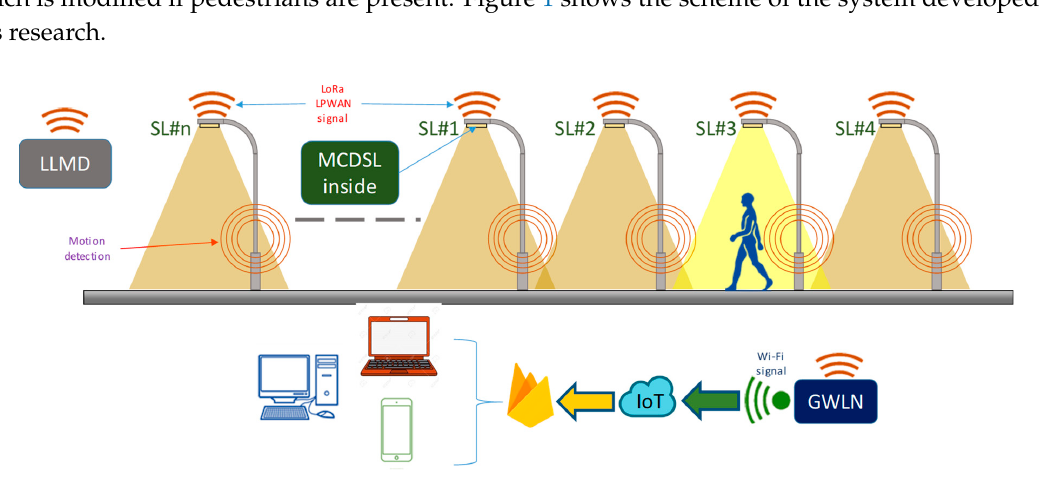
Figure 1. Architecture of SLs in campus.